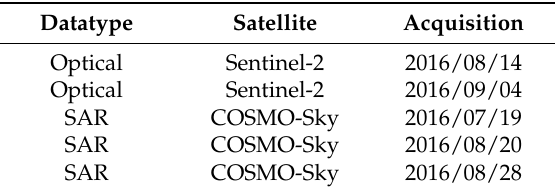
Table 2. EO data list for NN application.